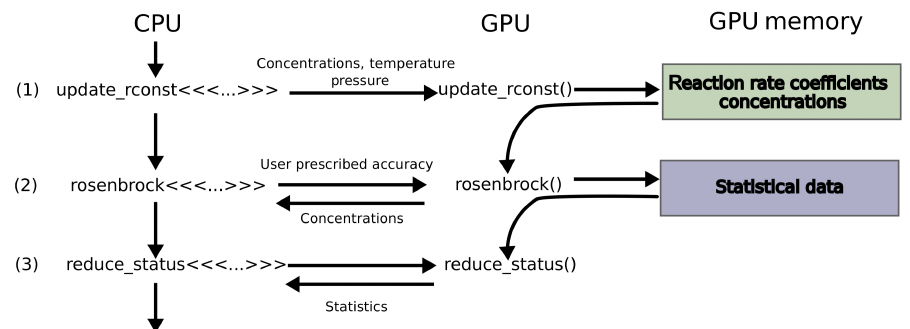
Figure 2. Flow chart of the tasks’ offload execution on GPU